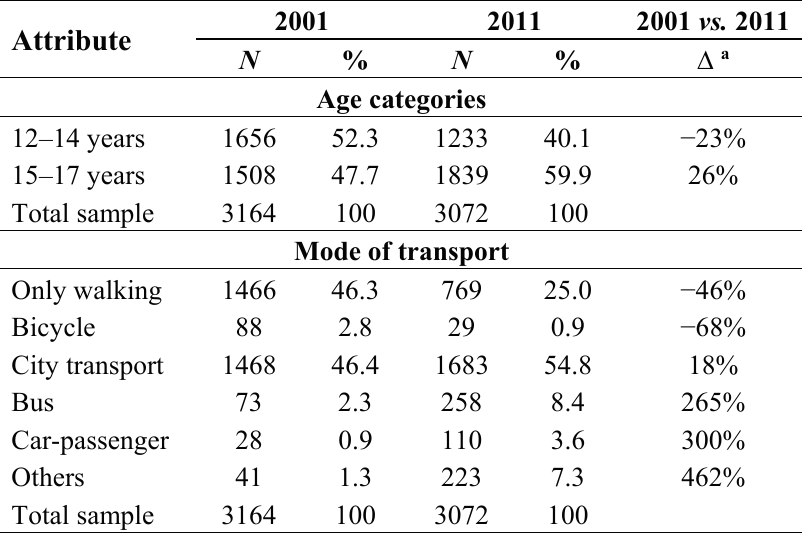
Table 1. Descriptive statistic of study